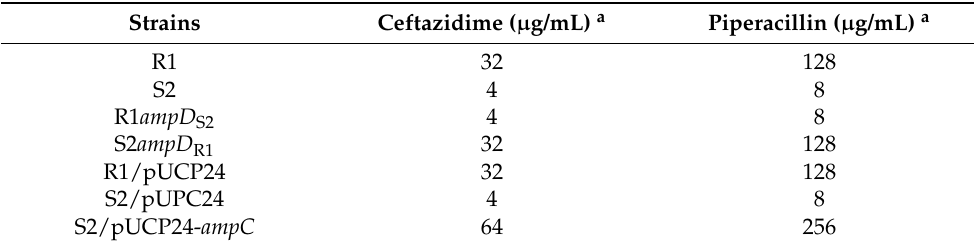
Table 1. MICs (µg/mL) of the indicated P. aeruginosa strains. Table 1. MICs ( µ g/mL) of the indicated P. aeruginosa strains. Strains